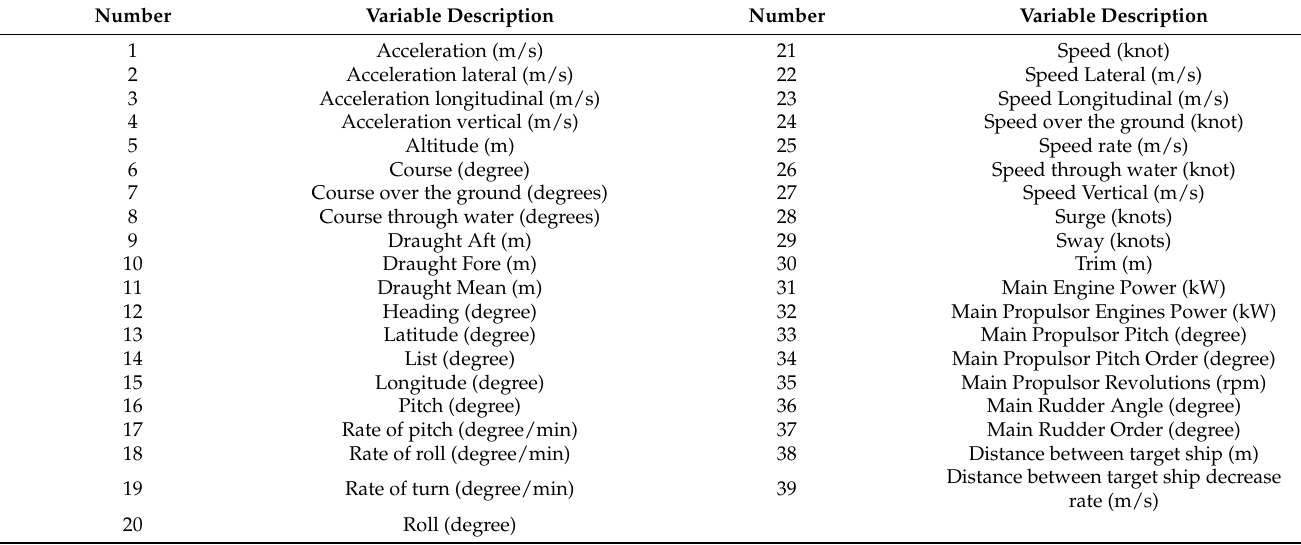
Table 2. Variables obtained after